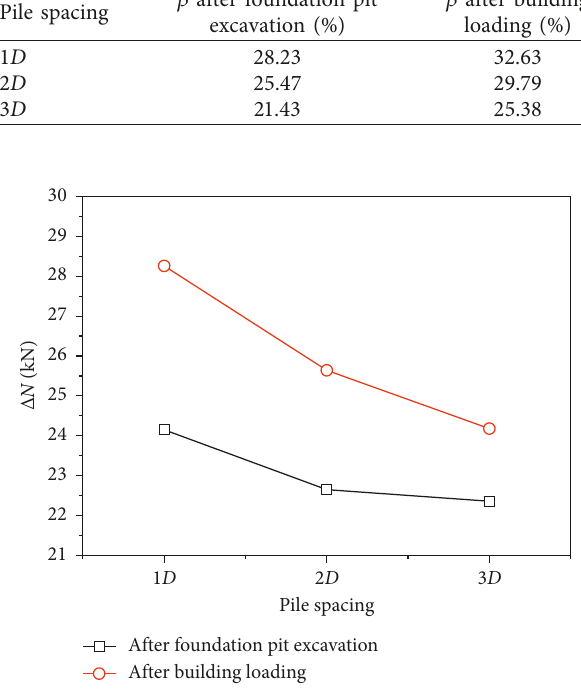
Figure 35: Difference between the additional normal forces.